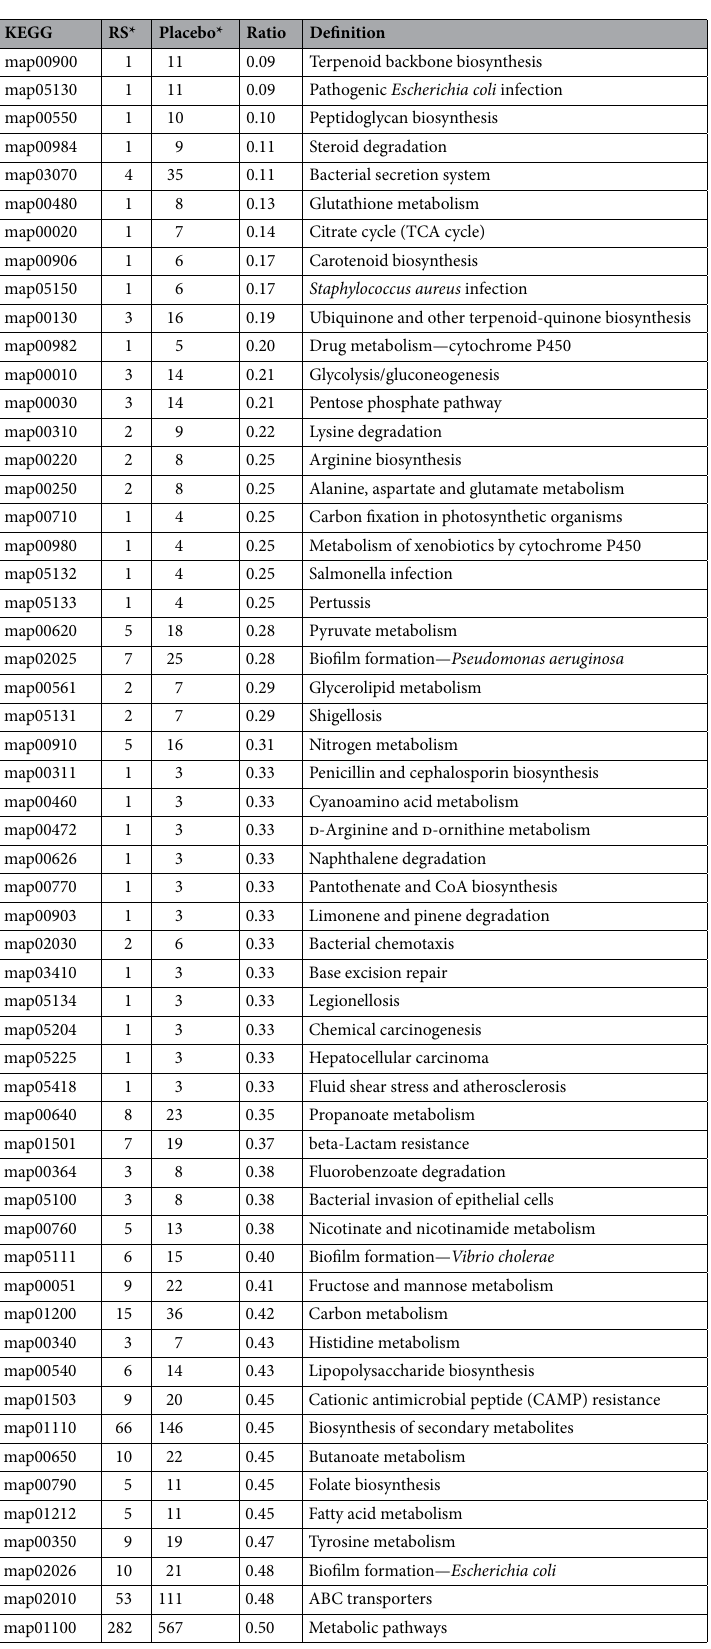
Table 3. Pathways differentially expressed between RS and placebo group. *The values indicate the numbers of KOs in each